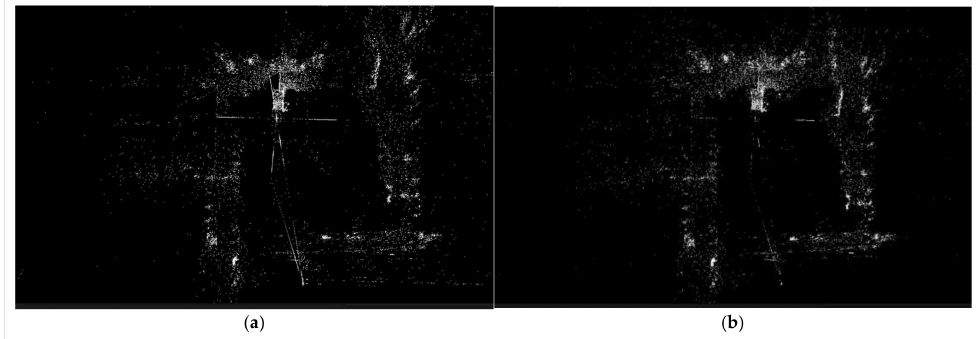
Figure 10. Optimization results: ( a ) before optimization; ( b ) after